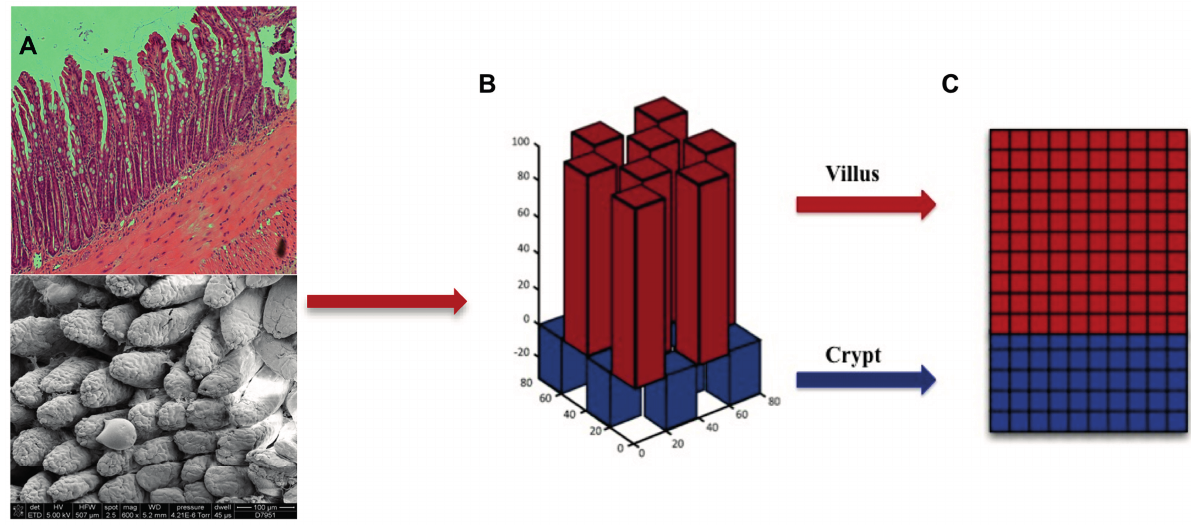
Figure 2. Crypt-villus architecture for Spatially Explicit General-purpose Model of Enteric Tissue (SEGMEnT) model. Panel ( A ) shows a histology cross section of ileal tissue (top) and scanning electron microscopy of the mucosal surface of ileum (bottom). Panel ( B ) is the topology used by SEGMEnT where crypts and villi are represented with a matrix of rectangular prisms. Each crypt and villus is mapped onto a two-dimensional grid (Panel ( C )), where signaling interactions, morphogen diffusion and cellular actions take place. The topology can be replicated and extended to represent any size piece of